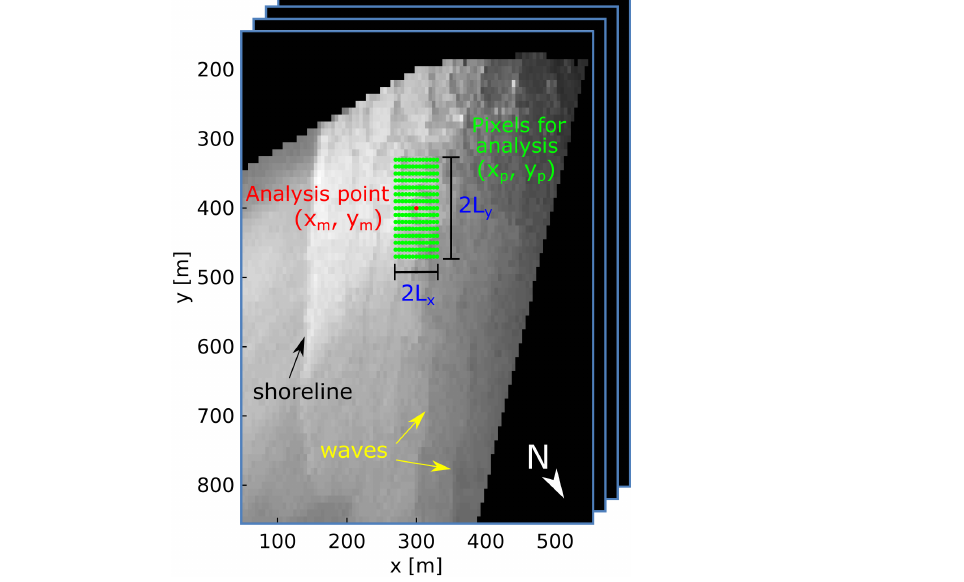
Figure 3. Pixel array used for cBathy analysis. Time series are collected at every pixel. Analysis at any example location (e.g., red dot) is based on data from the surrounding tile of pixels (green dots) of size +/ − L x and L y . The image is rotated, since cBathy assumes that the x-axis increases